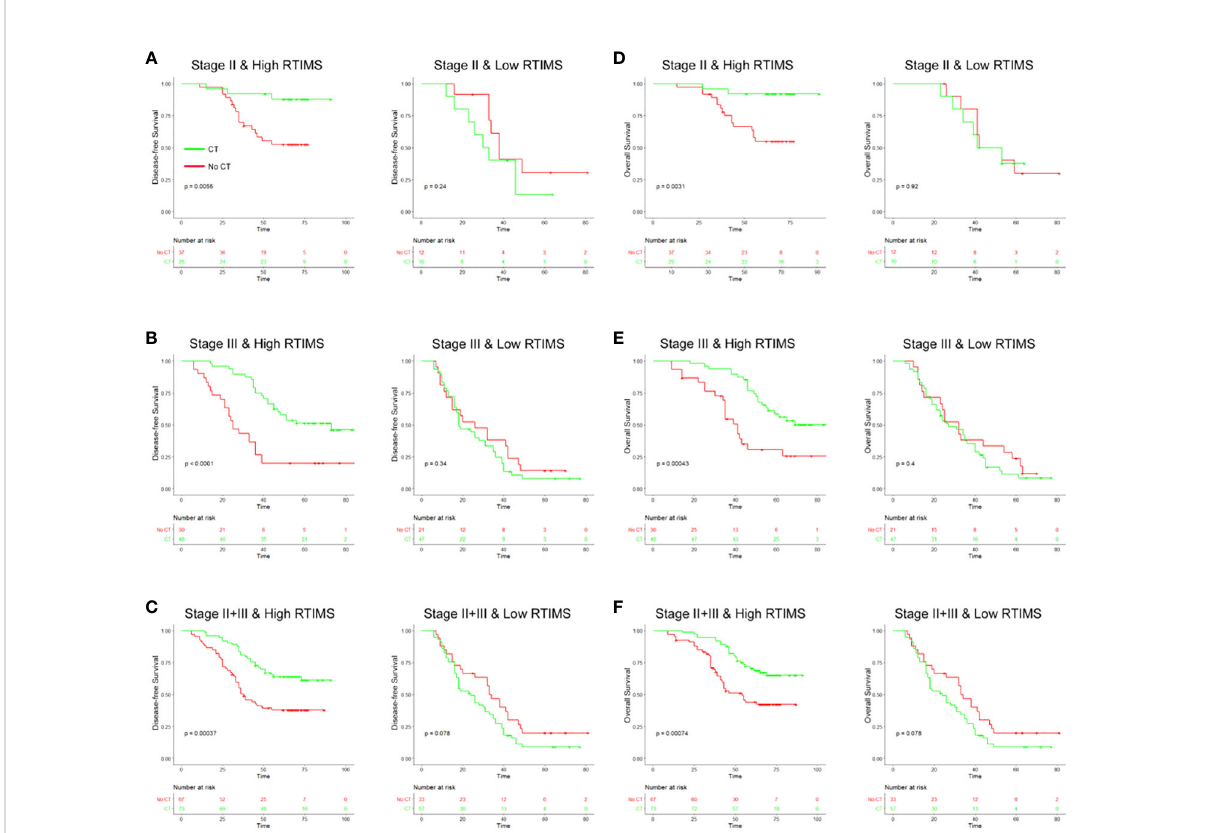
FIGURE 5 Relationship between the RTIMS signature and survival bene fi t from adjuvant chemotherapy in patients with stage II and III gastric cancer. In stage II, stage III and stage II+III patients, adjuvant chemotherapy improved DFS (A – C) and OS (D – F) for patients with high RTIMS, whereas no effect on survival was observed in patients with low RTIMS. RTIMS, radiomics tumor immune microenvironment